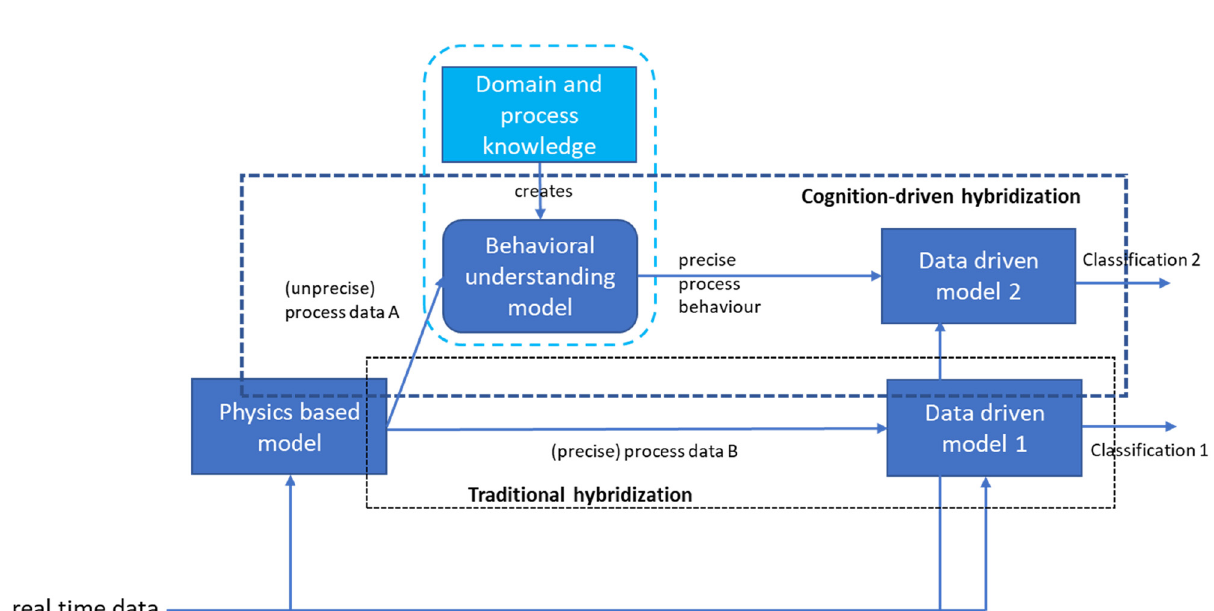
Figure 2: Cognition as an enabler of behavior